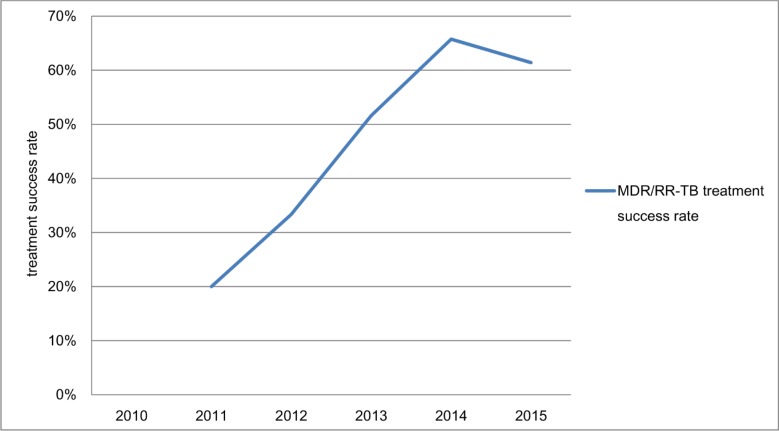
The MDR/RR-TB treatment outcome without imputed missing data.